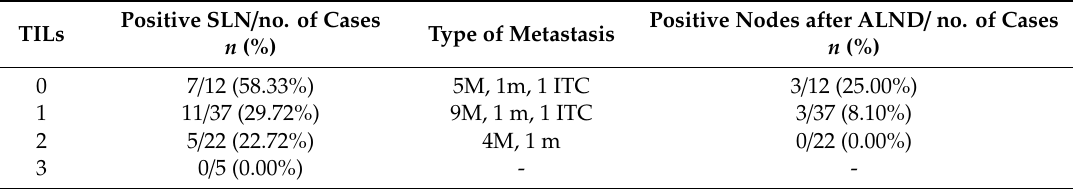
Table 2. Lymph nodes status according TILs values in the PST group.